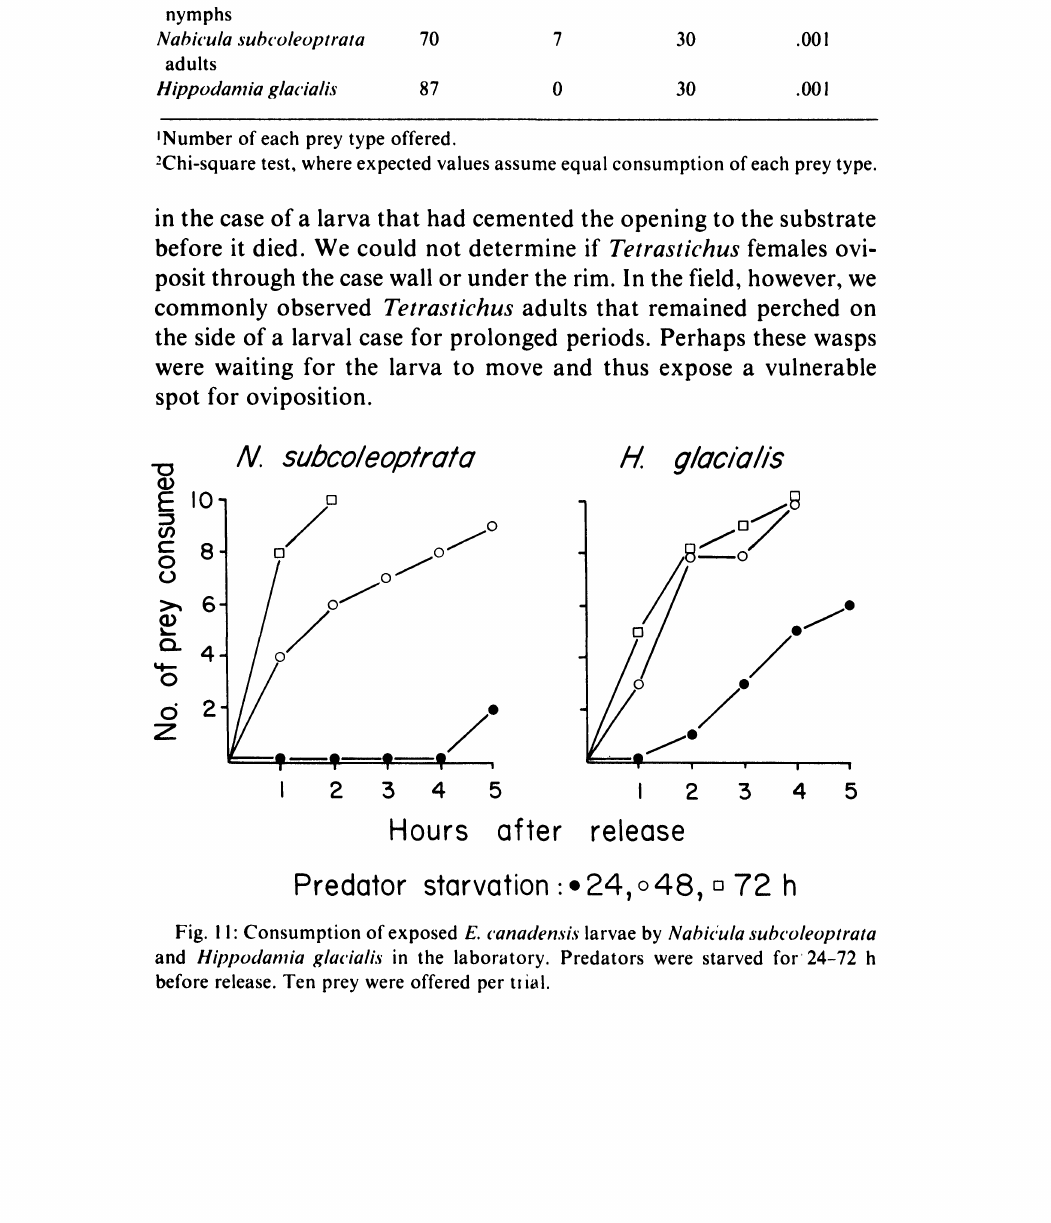
Psyche [Vol. 90 Table 2: Consumption of exposed and encased larvae of E. canadensis by three arthropod predators in laboratory arenas. % available prey consumed Predator Exposed Encased N P- Podisus maculiventris 69 19 54 .00 nymphs Nabicula subcoleoptrata 70 7 30 .001 adults 87 0 30